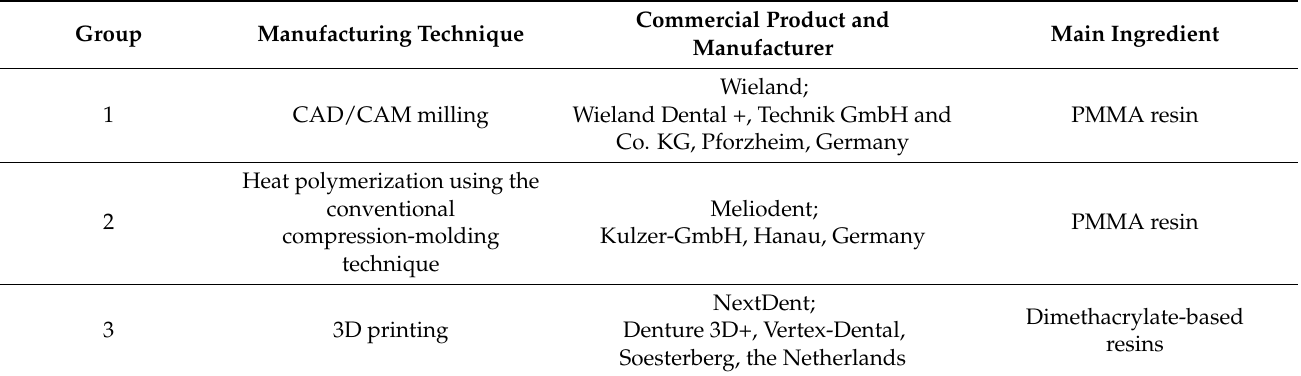
Table 1. Details of the denture base resins used in this